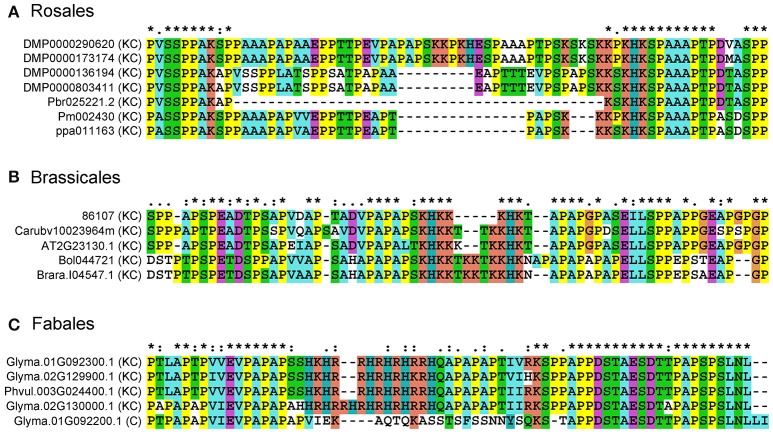
Multiple sequence alignments of representatives from classical and Lys-rich classical AGPs. Amino acid sequences were aligned using the Clustal X 1.83 program with default parameters to show the deletion/insertion model amongst classical and Lys-rich classical AGPs. (A) Lys-rich classical AGPs from Rosales; (B) Lys-rich classical AGPs from Brassicales; (C) classical and Lys-rich classical AGPs from Fabales. The asterisk (*), colon (:), and dot (.) represent different conservative level from high to low.